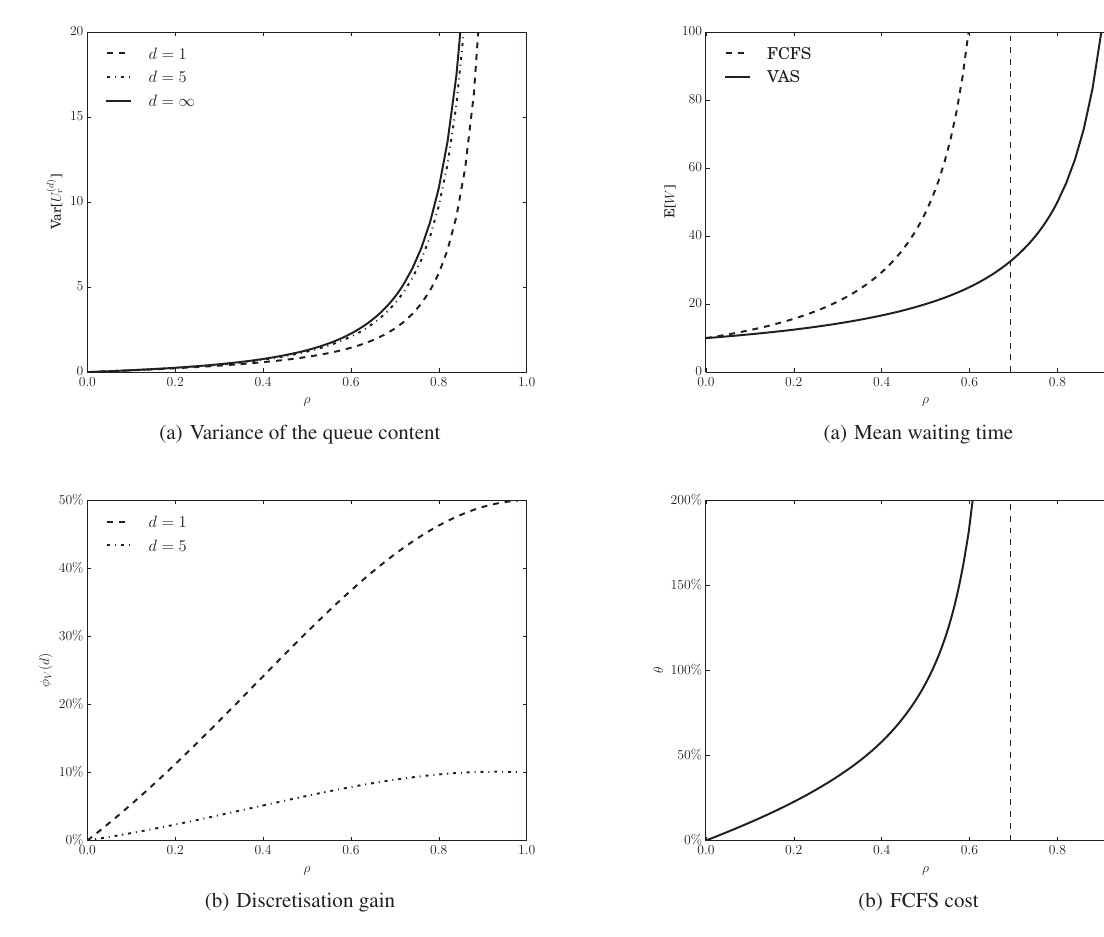
Figure 6: Mean waiting time versus the load ρ for VAS and FCFS (a) and the relative cost θ for FCFS